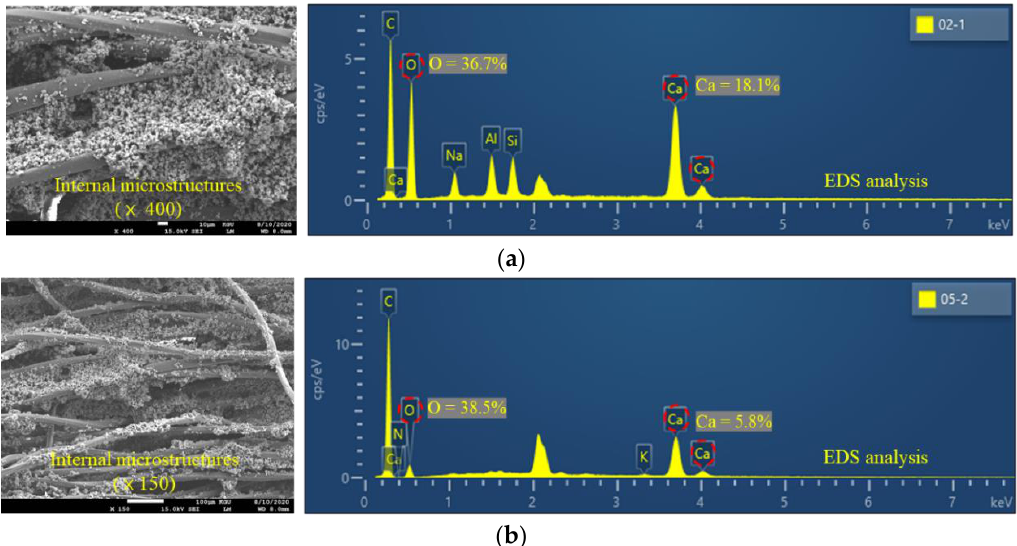
Figure 10. SEM images and EDS spectra of textile fabric coated with zeolite. ( a ) Before washing. ( b ) After 10 washings and one freeze–thaw cycle.